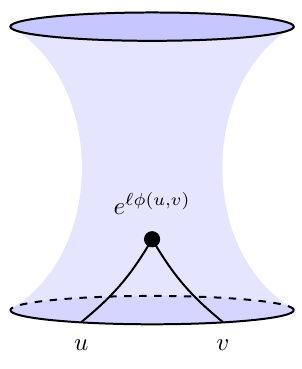
Figure 5 . The kinematic space of the Schwarzian theory. The bi-local operator (4.1) in the 1D QM is represented by a local Liouville CFT vertex operator in the 2D bulk. The boundary of the kinematic space corresponds to the limit where the two end-points of the bi-local operator